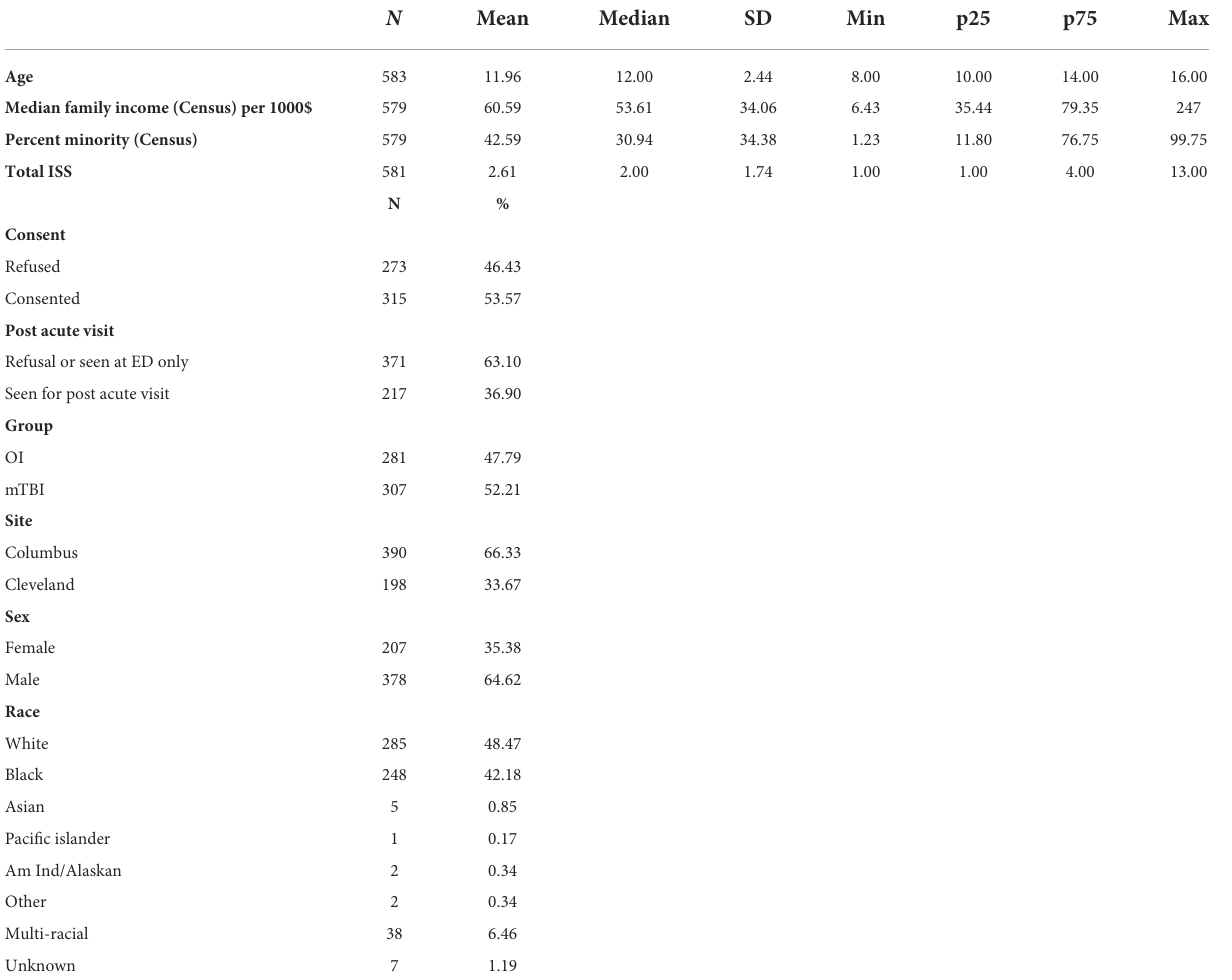
TABLE 1 Characteristics of eligible children ( N =